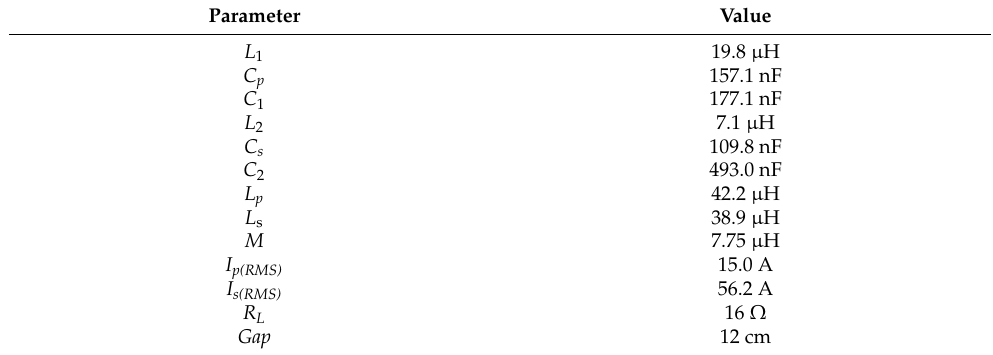
Table 1. WPT system parameters.